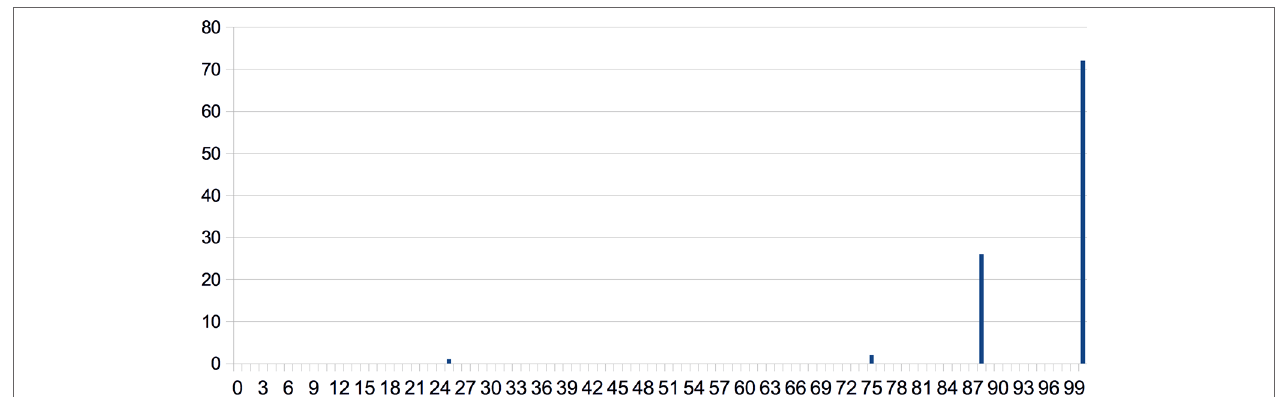
FIgURe 1 | Results of the CG in the social perception condition graphed in a Cartesian coordinate system. Response rates (in %) are shown along the x-axis and ratios of those who achieved the given response rates (in %) can be found along the y